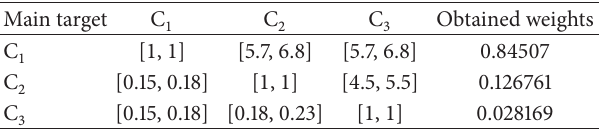
Table 11: The interval approximation main target concerning the gain criteria.